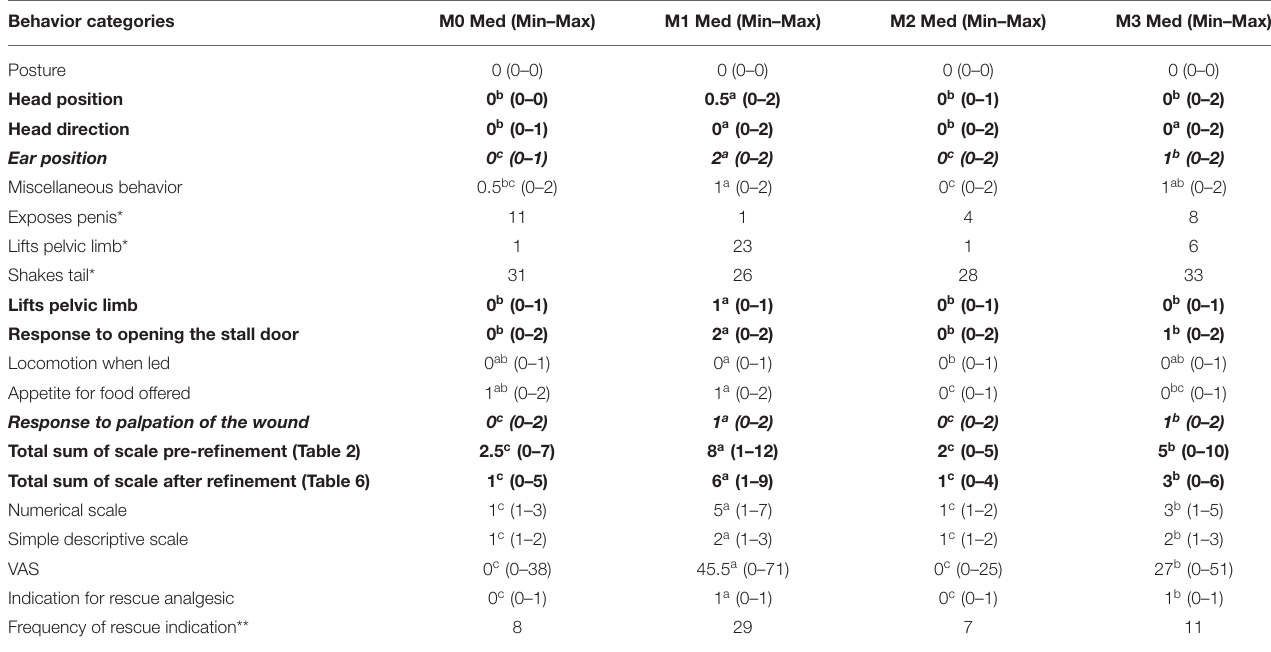
TABLE 4 | Median and amplitude of the indication for rescue analgesic and scores of the Donkey pain scale (DOPS) (pre- and after refinement) and unidimensional scales to evaluate acute pain in 40 donkeys submitted to orchiectomy, over time. Behavior categories